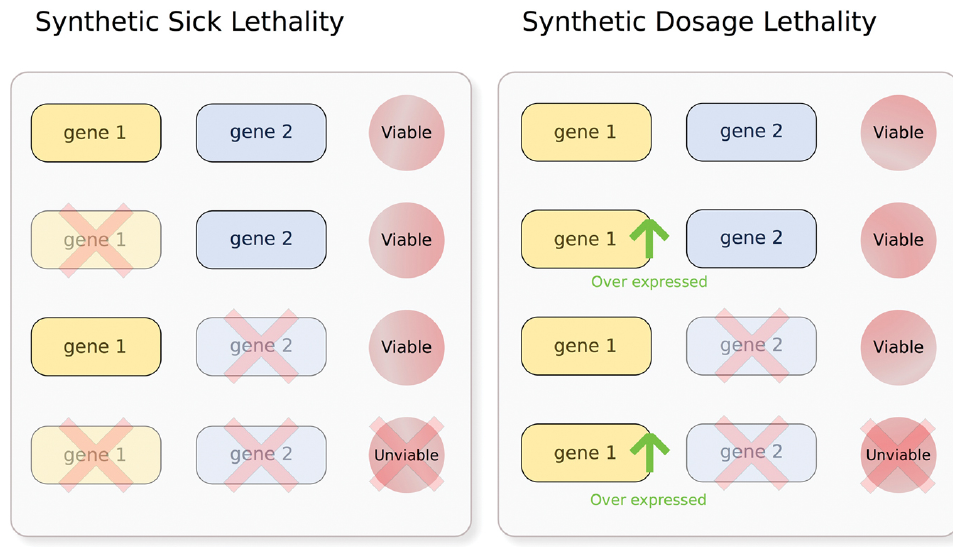
Figure 1: Schematic illustration of synthetic sickness lethality and synthetic dosage